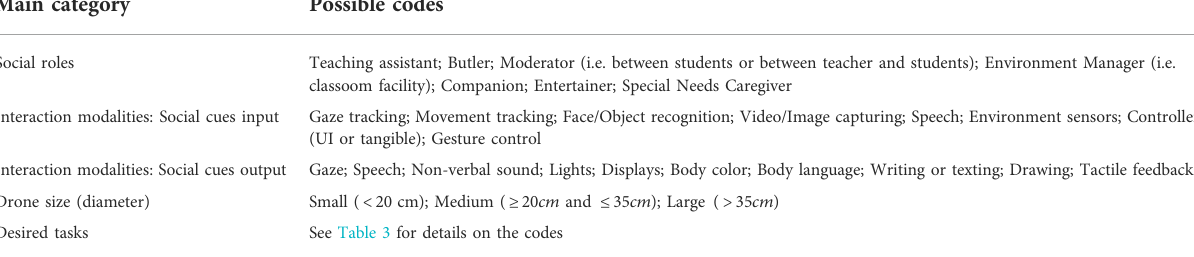
TABLE 2 Coding scheme used for the quantitative analysis with possible codes separated by “ ; ” for each